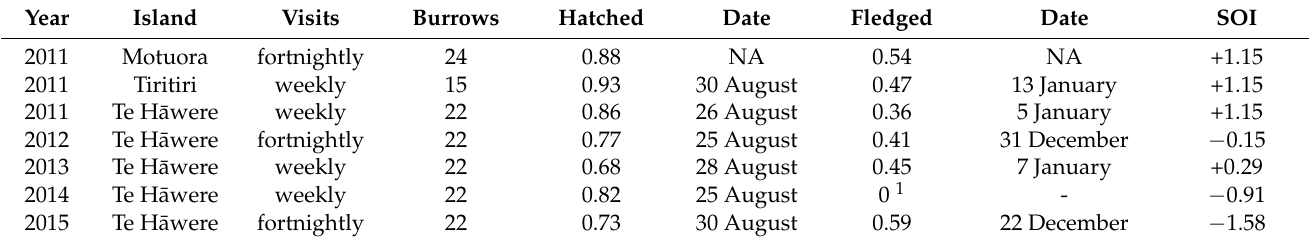
Table 1. Hatching and fledging proportions and average dates (estimated hatching date and last measurement prior to fledging) for burrows monitored from 2011 to 2015. SOI = Average South- ern Oscillation Index over the chick-rearing period from August to January (positive = La Niña, negative = El Niño). NA = not available.